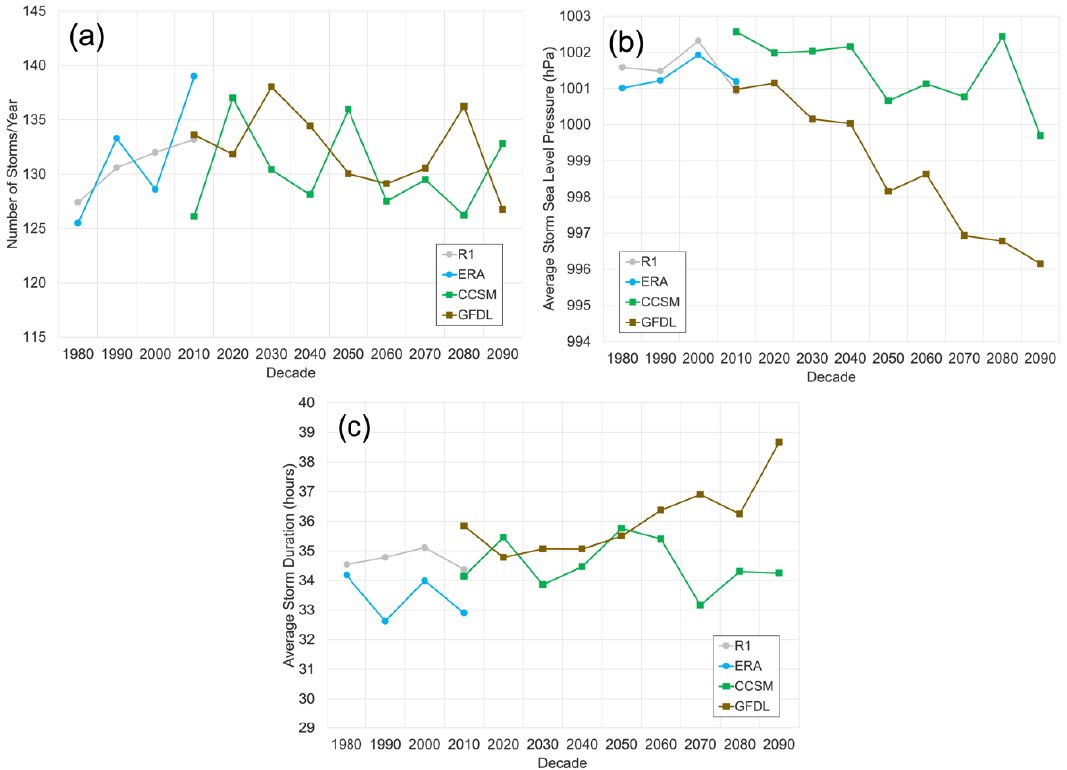
Figure 10. Historical and projected decadal average ( a ) number of storms per year, ( b ) central pressure of storms (hPa), and ( c ) storm duration (hours) for storms entering the region shown by the box in Figure 7. The decadal average counts of events in the CCSM and GFDL projections were delta bias-corrected using the historical mean difference from R1.